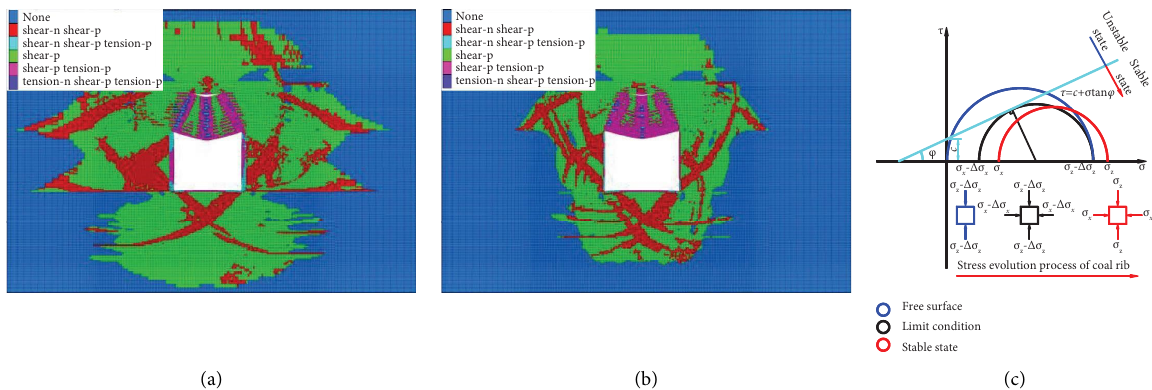
Figure 12: Infuence of the rib bearing capacity: (a) weak rib; (b) strong rib; (c) stress evolution